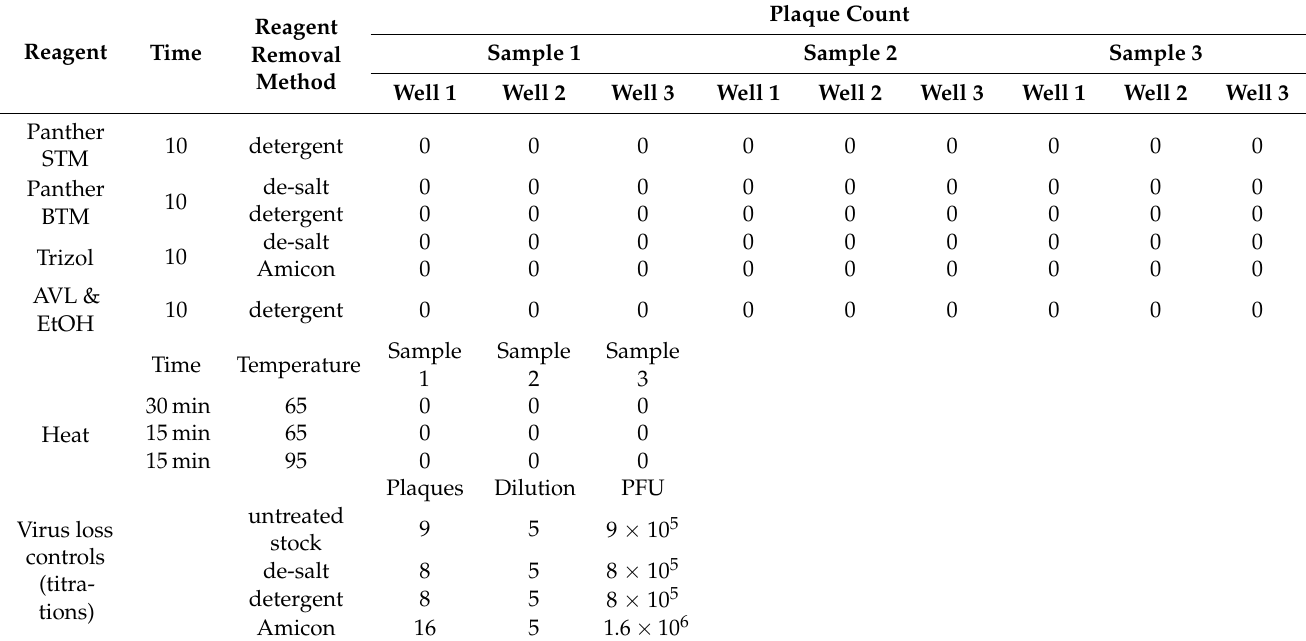
Table 4. Results of MPXV inactivation testing using various methods and three reagent removal meth-